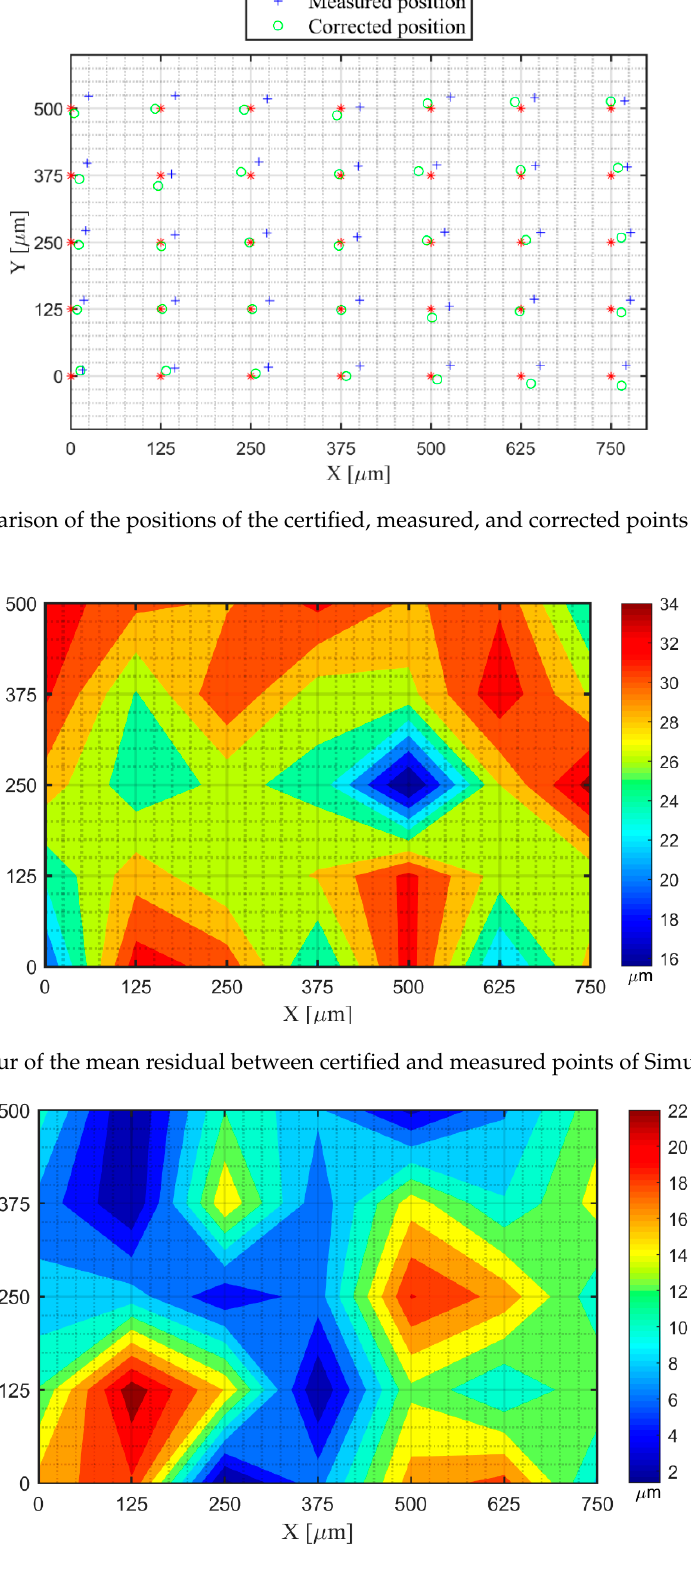
Figure 22. Contour of the mean residual between certified and corrected points of Simulation No. 10.